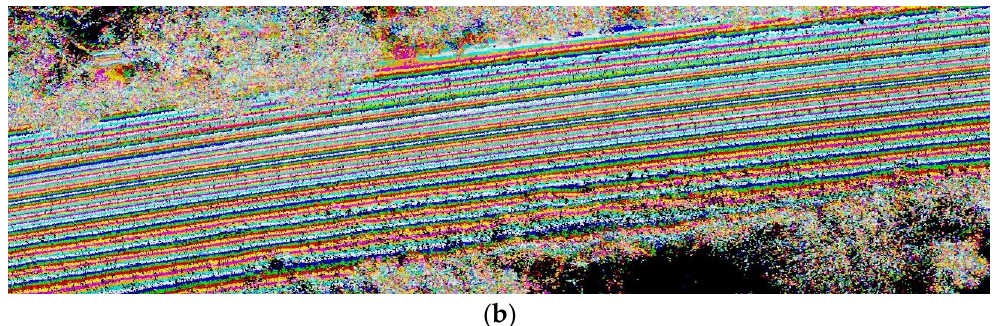
Figure 2. Point cloud sample obtained by an MLS installed in a train along a railway line: ( a ) Grayscale representation intensity values; ( b ) Coloured point cloud based on scan angle values converted to 255 values.